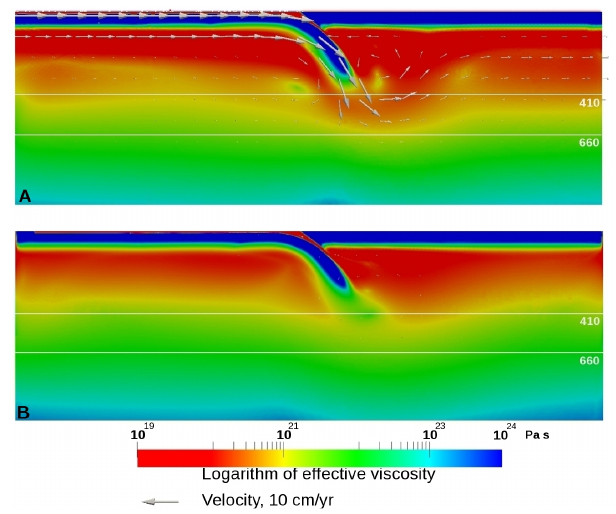
Fig. 1. The rheology and flow field after the initial 3.5My of kine- matically forced subduction consistent with (A) – open sidewalls, (B) – closed sidewalls. The colour scale shows 10-logarithm of ef- fective viscosity. White lines corresponds to the approximate posi- tion of phase transition zones at 410km and